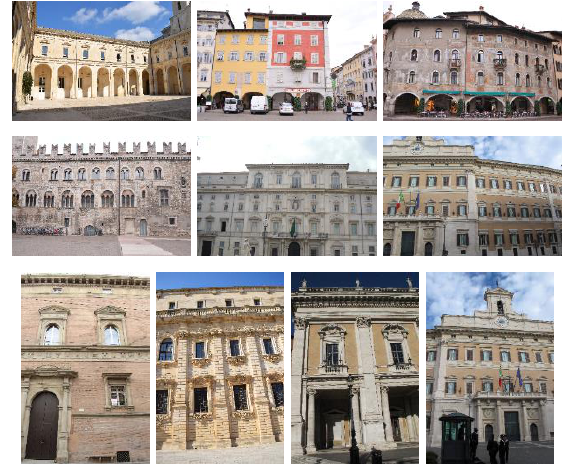
Figure 3: Example of the historic building façades used in our tests to train a CNN for automatic semantic